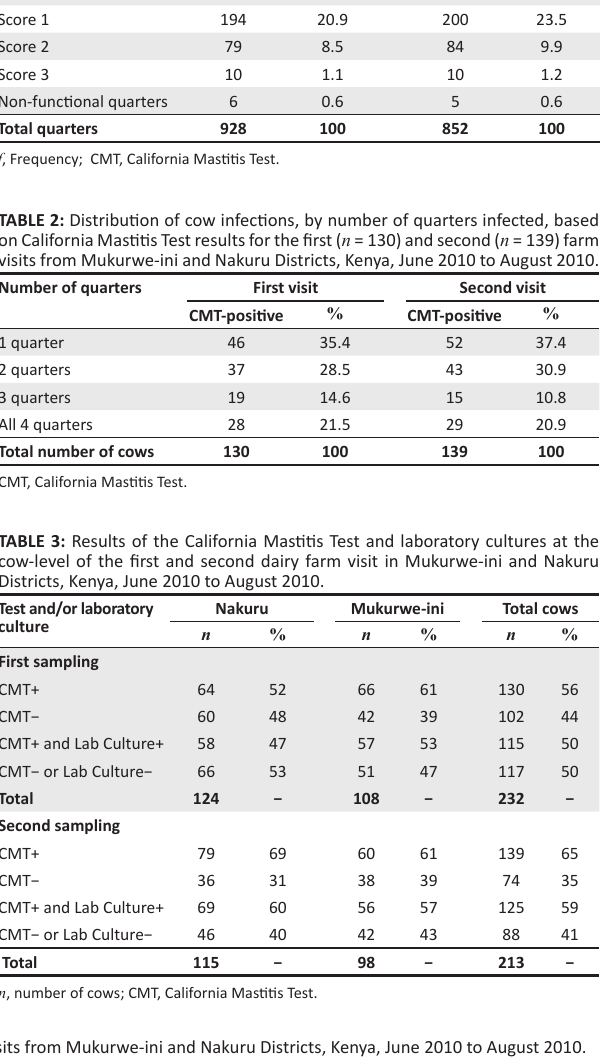
TABLE 4: Laboratory culture results at the cow-level for the first and second dairy farm visits from Mukurwe-ini and Nakuru Districts, Kenya, June 2010 to August 2010.